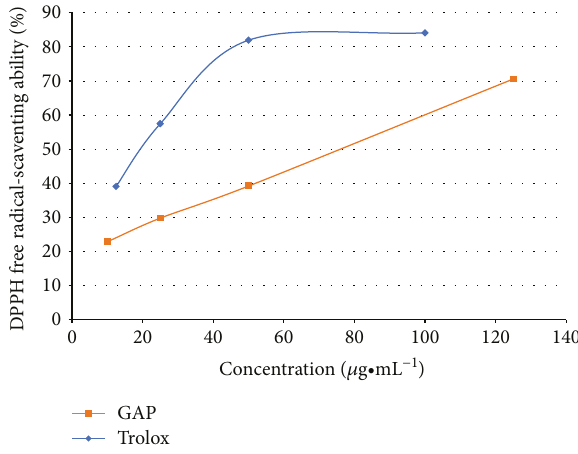
Figure 7: Antioxidant activities of GAP in DPPH free radical- scavenging